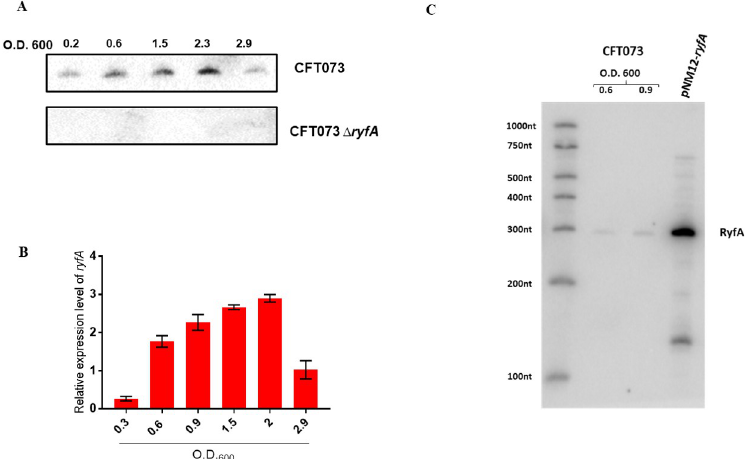
Fig 2. CFT073 produces RyfA in mid-logarithmic phase. ( A ) Northern blot analysis using 10 mg of total RNA isolated from WT CFT073 following growth in LB medium at 37˚C. Lack of signal in Δ ryfA strain confirms absence of RyfA in the Δ ryfA strain. ( B ) Quantitative real-time PCR (qRT-PCR) analysis demonstrating that RyfA is produced by wild-type CFT073 under the conditions tested. ( C ) Northern blot showing RyfA expression in a strain overexpressing